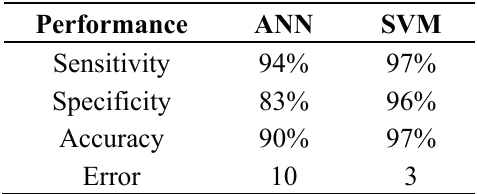
Table 6. Performance of the classification